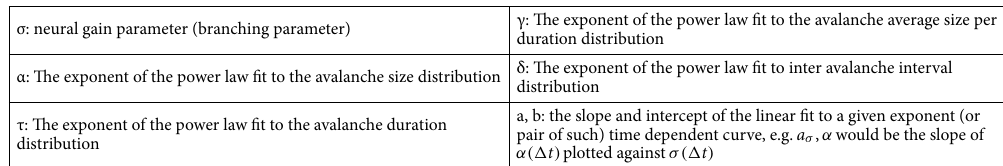
σ: neural gain parameter (branching